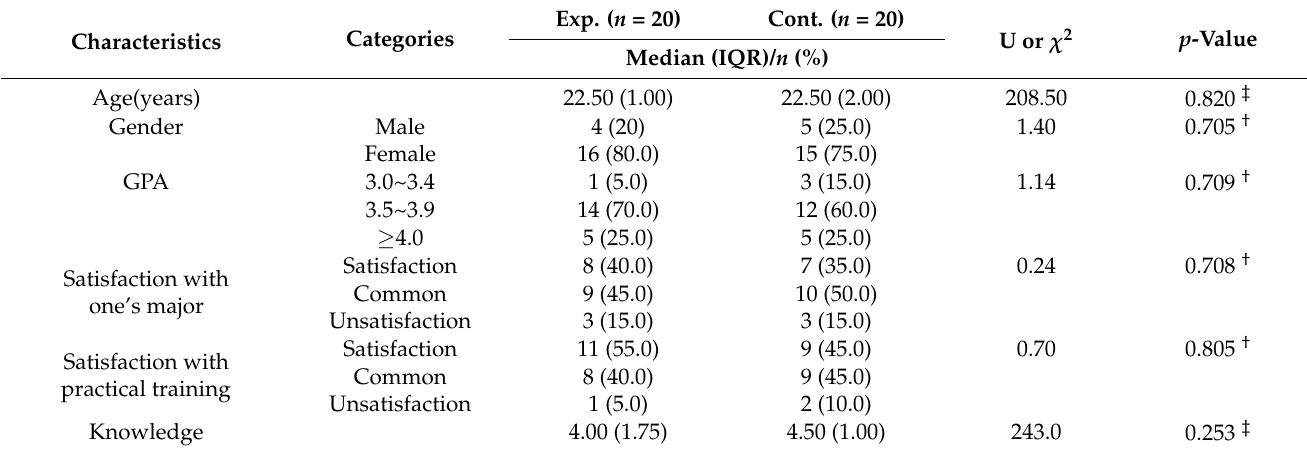
Table 1. General characteristics of participants ( n = 40).